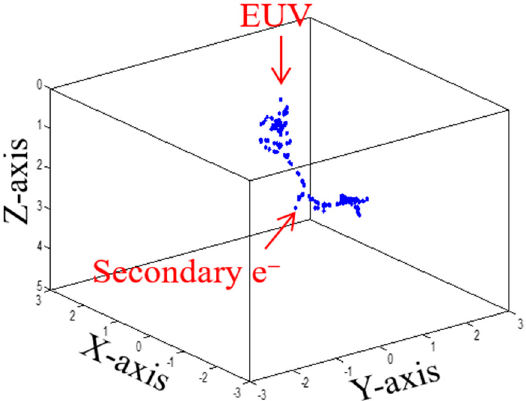
Figure 3. Exposure simulation of Monte Carlo method: a photoelectron and secondary electron trajectories with EUV energy (92.5 eV) due to elastic and inelastic scattering (collision) of a photoelectron with an atom in a polyhydroxystyrene (PHS)-based chemically amplified resist.